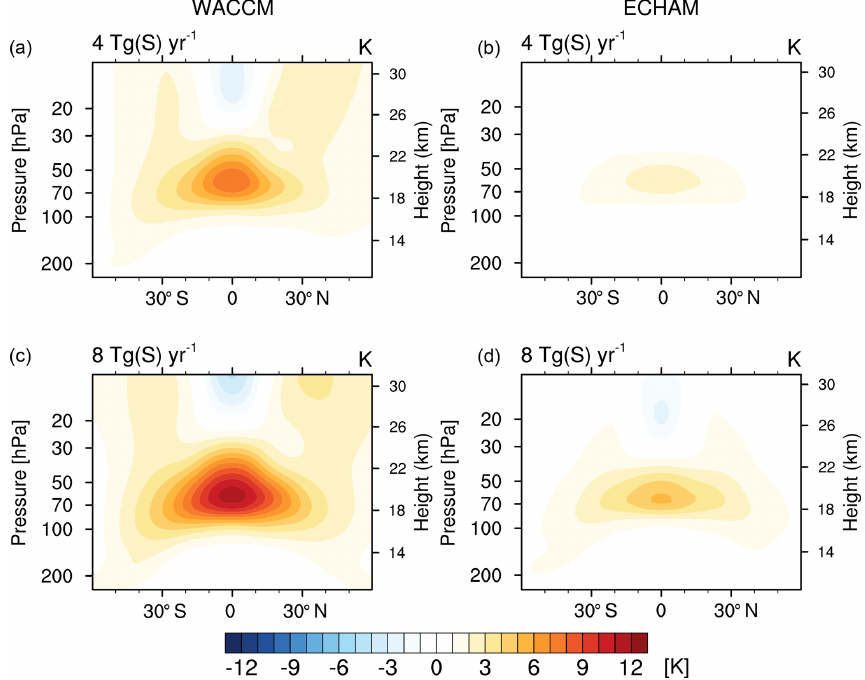
Figure 2. Temperature anomaly (K) caused by injections of 4Tg ( S ) yr − 1 (a, b) and 8Tg ( S ) yr − 1 (c, d) of sulfur. (a, c) Results of WACCM. (b, d) Results of